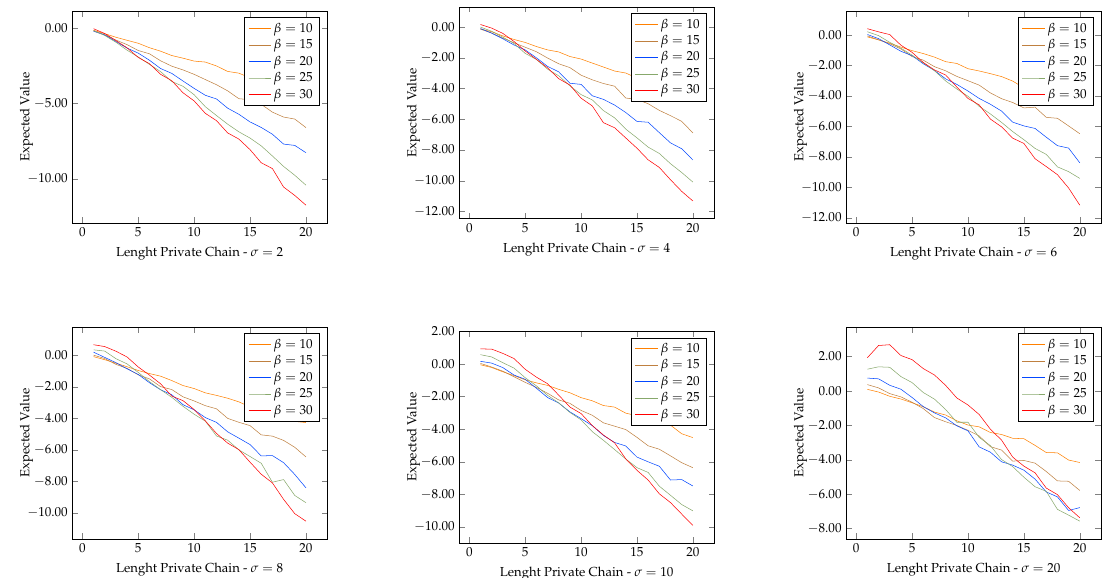
Figure 6. The graphs show that positive expected values can be obtained only with significant values of σ and β